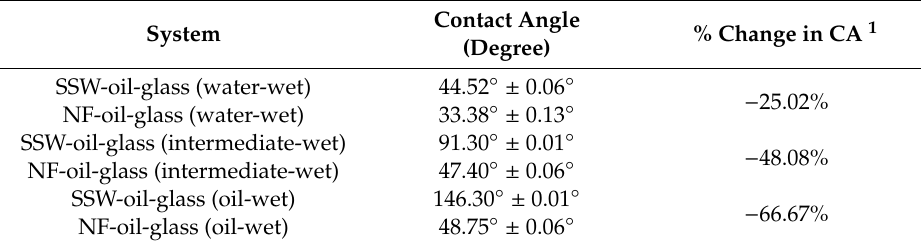
Table 4. Fluid-solid interactions indicated by contact